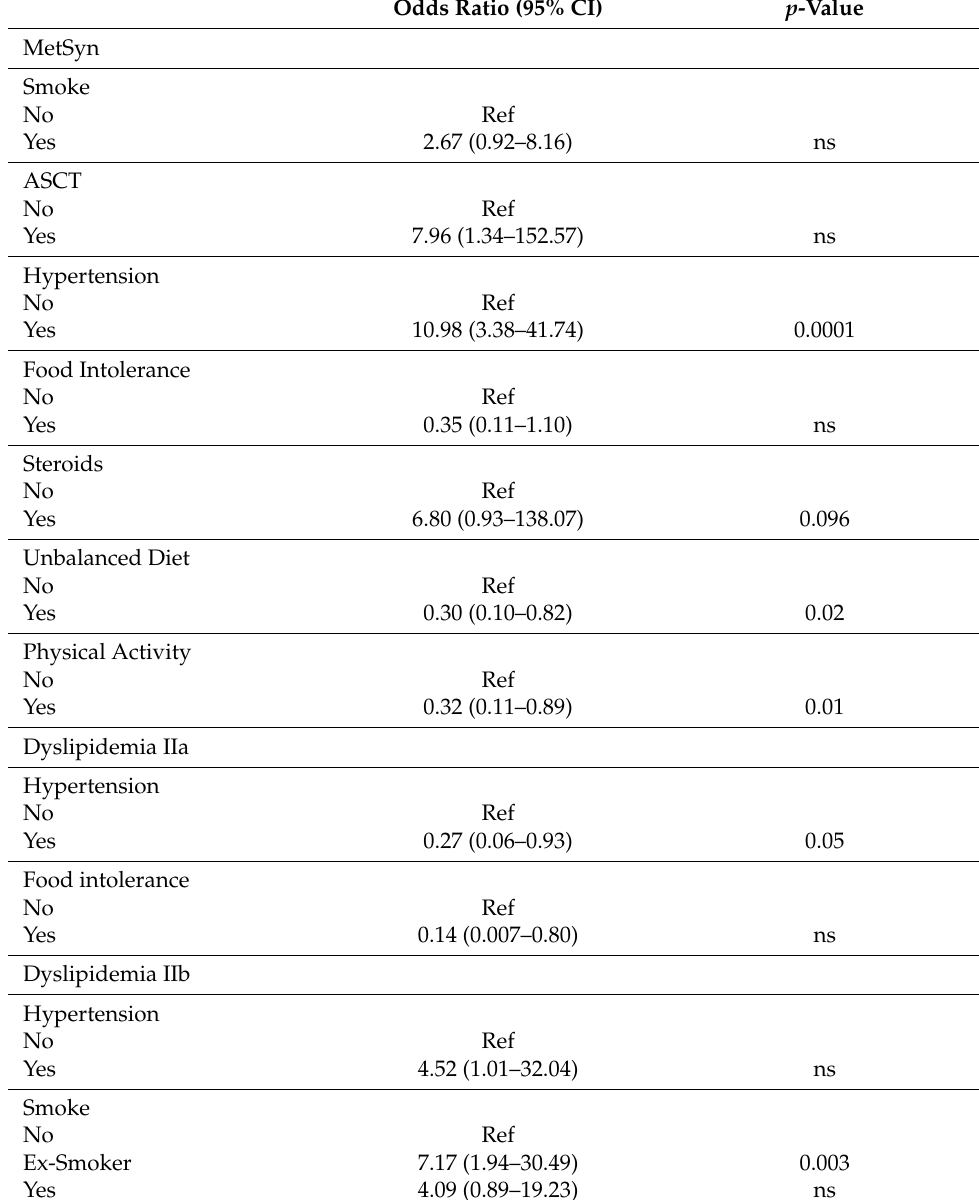
Table 3. Univariate logistic regressions, with metabolic syndrome, dyslipidemia IIa and dyslipidemia IIb as dependent variables (statistically significant results have been reported, including statistical